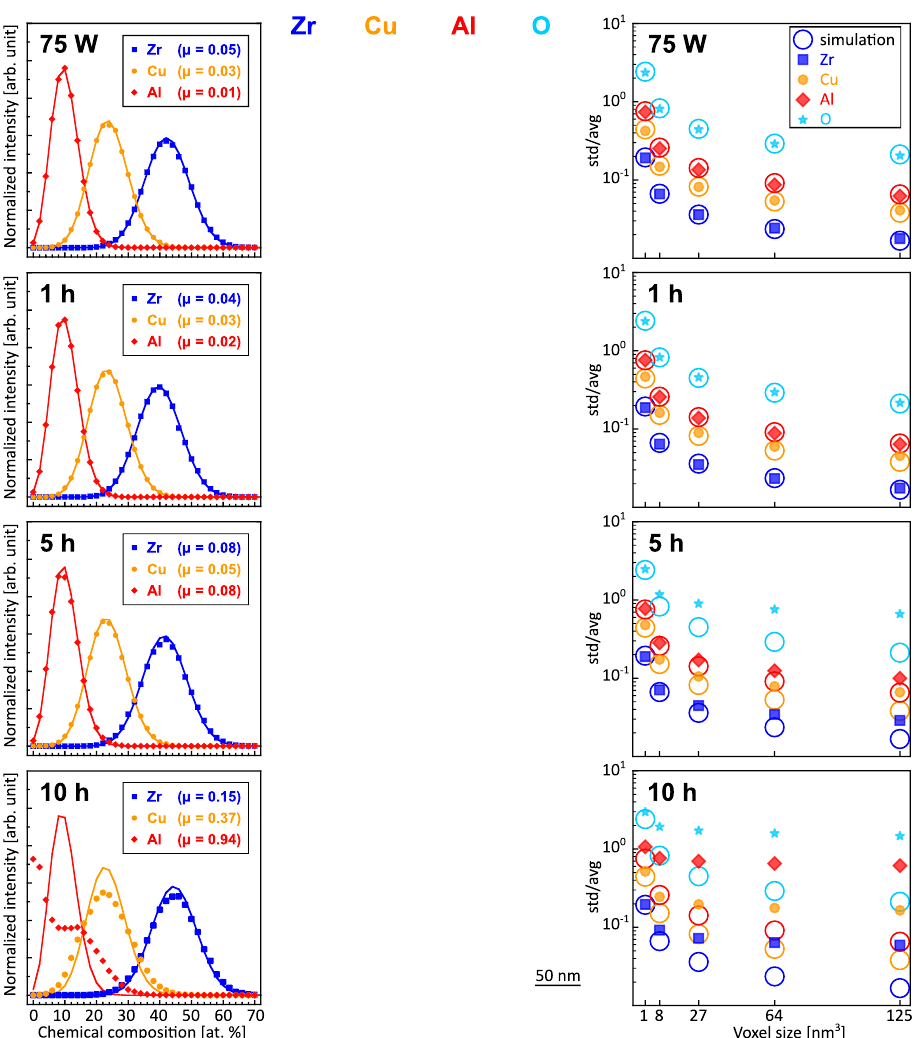
Figure 2. APT reconstructions of the samples processed with 75 W and annealed for 0, 1, 5, and 10 hours at 390 °C. The frequency distribution analysis (calculated in IVAS 3.8.0 with bins of 50 ions) shows the concentration of the ions per voxel in comparison to a binomial distribution. Standard deviation (std) divided by average (avg) for the local elemental concentrations compared to the random simulation.